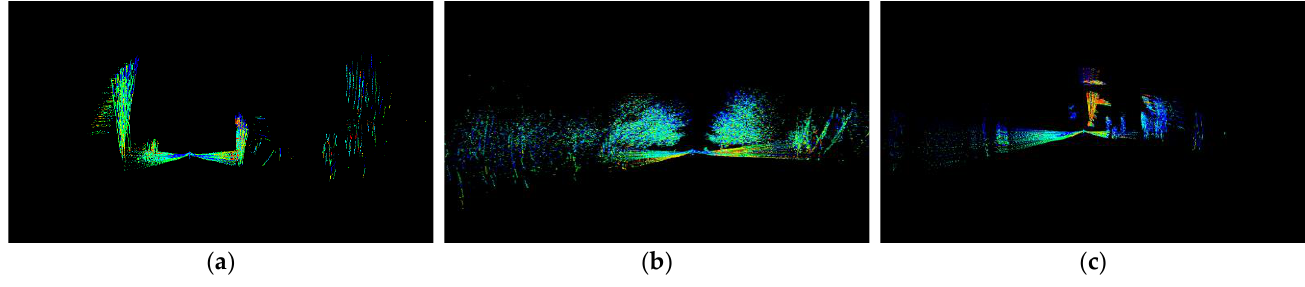
Figure 14. Point cloud image scene 10: Mason-Hall-S16 ( a ) Picture 1, ( b ) Picture 2, ( c ) Picture 3.